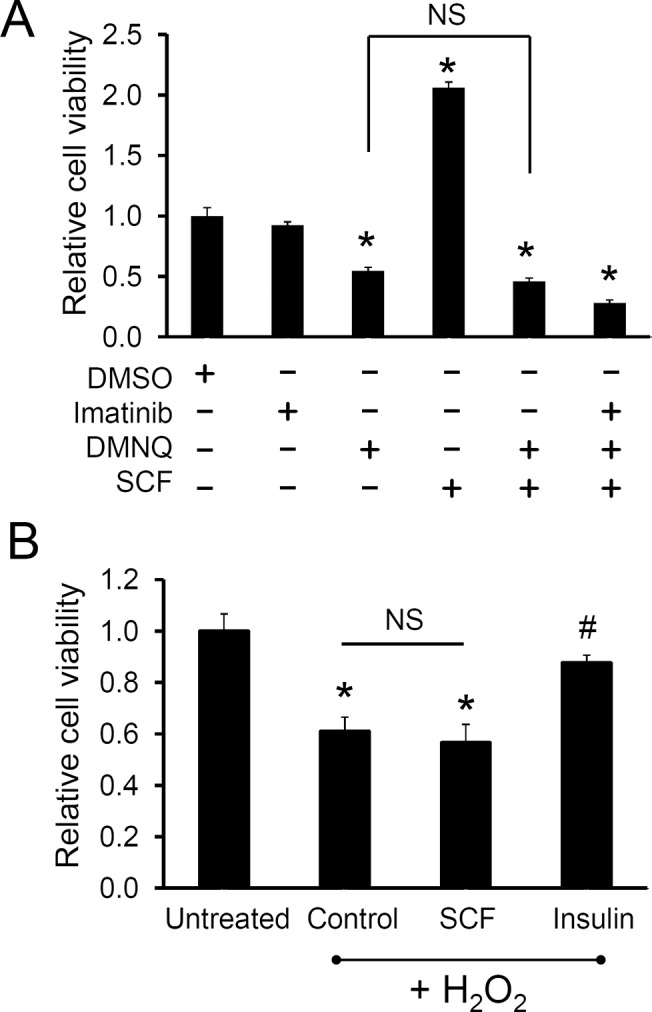
c-kit activation does not rescue CPCs from oxidative stress.A, Human c-kit+ CPCs were pre-treated with SCF for 24 hr in serum free media and subjected to 8 μM DMNQ treatment. B, Cells pre-treated with or without SCF received 1 hr treatment in 0.5 mM H2O2, followed by media change with or without SCF. Insulin was used as a positive control. Cell viability was assessed after 3 days using PrestoBlueTM. *, p<0.05 compared to the untreated control, #, p<0.05 compared to the H2O2 only control. NS, no statistical significance. Values presented are mean ± SEM. *, p<0.05.